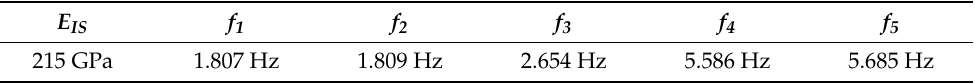
Table 2. Elastic modulus of steel ( E IS ) and natural frequencies ( f j ) of the updated Gageocho FE model. E